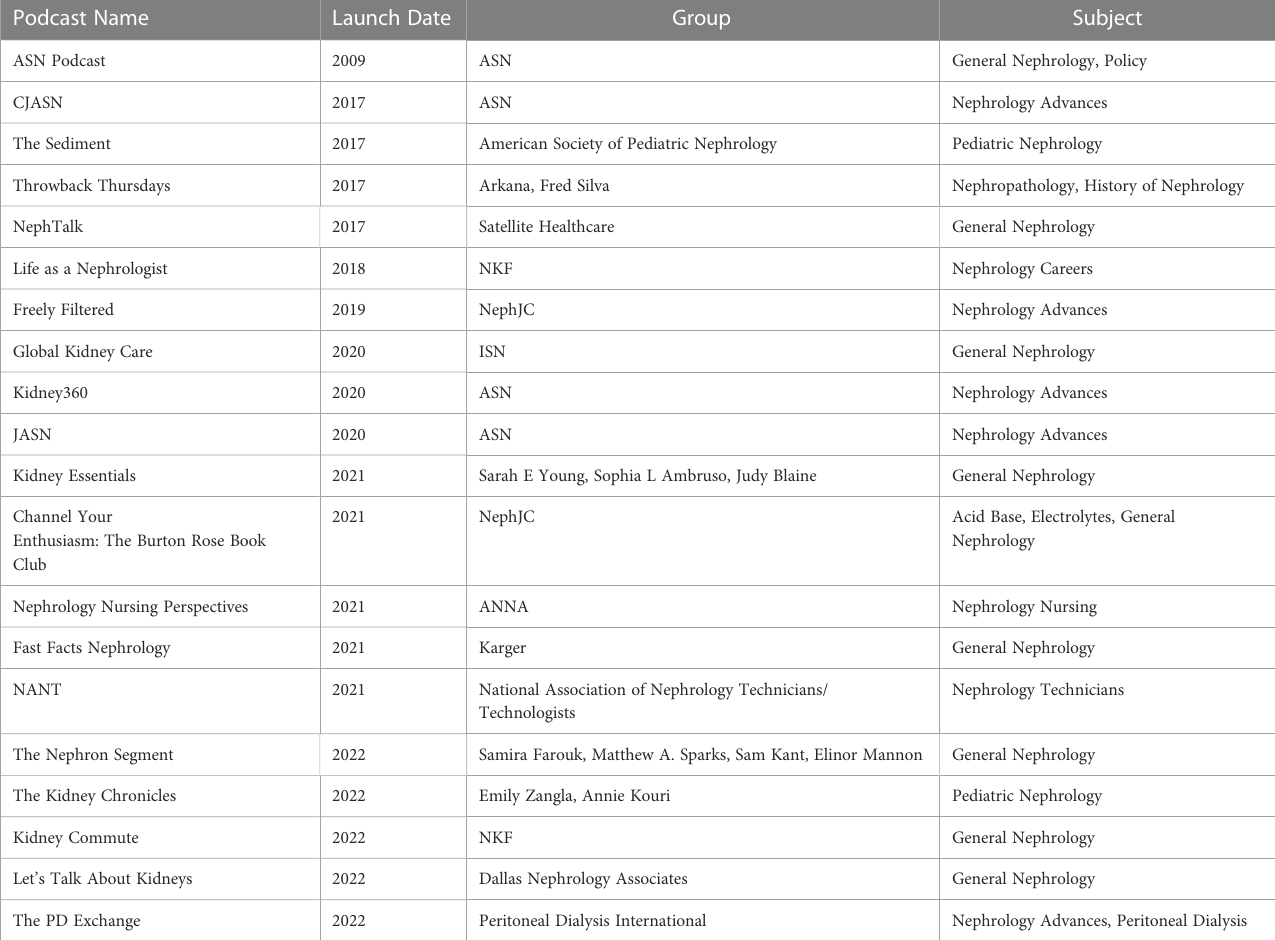
TABLE 1 List of Nephrology